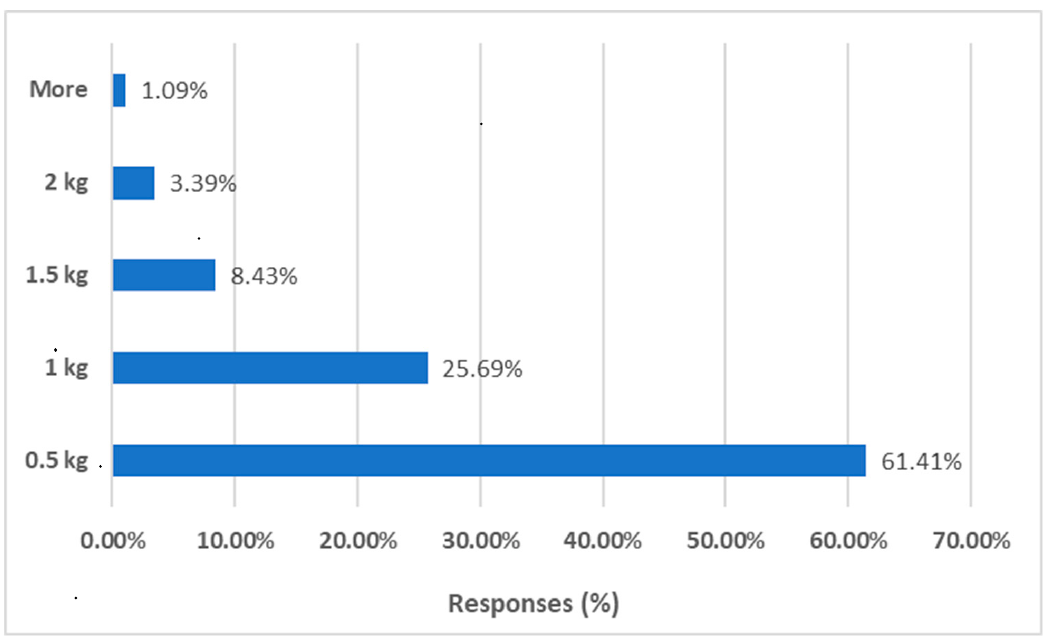
Figure 6. Responses to the question, “How many kilos of food waste do you think that your household produces?”